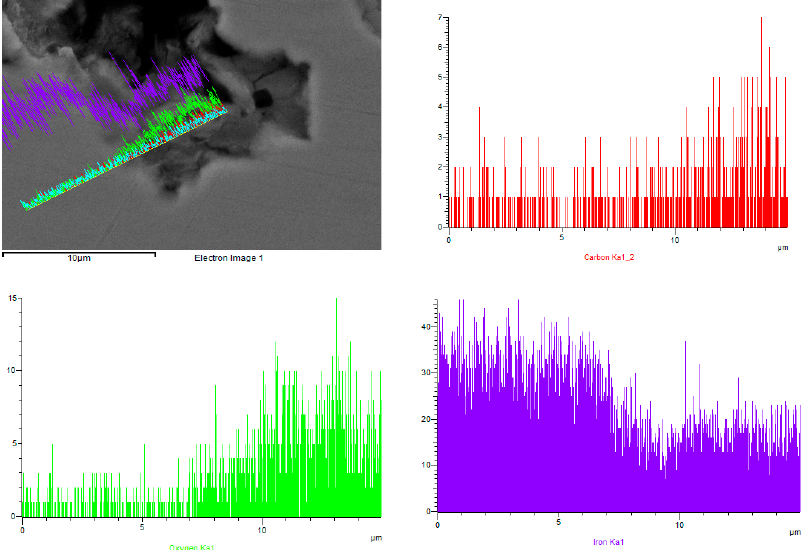
Figure 9. Image of the sample (test speed 500 rpm) surface (top left) and the change in elemental composition as a function of removal for carbon (top right), oxygen (bottom left), and iron (bottom right).